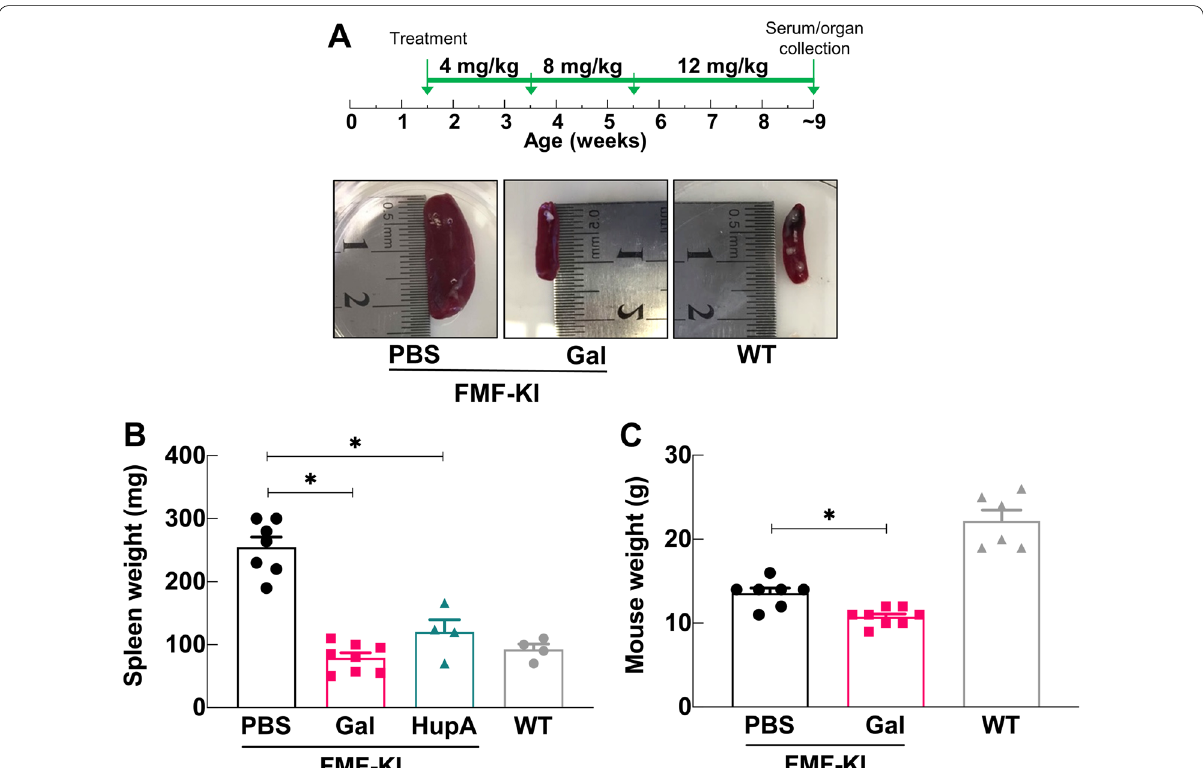
Fig. 1 Galantamine prevents massive splenomegaly in chronically treated FMF‑KI mice. A FMF‑KI mice were treated with an escalated dose of galantamine (4–12 mg/kg) or PBS twice daily for ~ 8 weeks starting at age 1.5 weeks (upper panel). The lower panels include representative images of FMF‑KI mouse spleens harvested at the end of treatment compared with wildtype (WT) spleen (weights: PBS 330 mg; gal 70 mg; = = WT 90 mg). B Spleen weights (mg) from galantamine‑, huperzine A‑, and PBS‑treated FMF‑KI mice compared with WT. FMF‑KI mice were treated = with huperzine A (1 mg/kg twice daily) for 4–5 weeks starting at the age of ~ 4 weeks and compared to the control group in the galantamine vs. PBS experiment (first column). (Data presented as mean SEM; * P < 0.025 by Mann–Whitney U test with Bonferroni correction). C Body weights (g) of ± galantamine‑ and PBS‑treated FMF‑KI mice at the end of treatment period. In all figures, wild type measurements are included for comparison